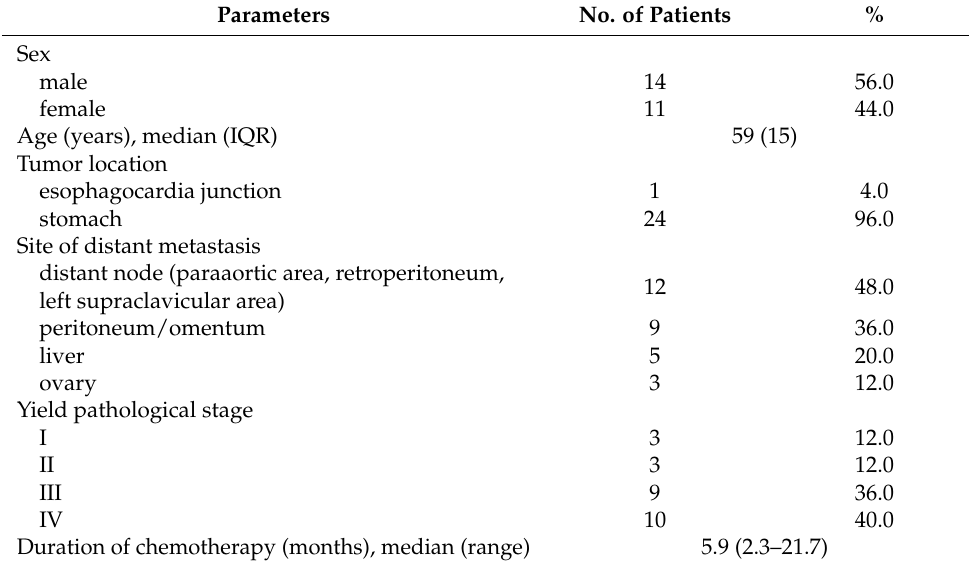
Table 2. Clinicopathological characteristics of conversion surgery patients.